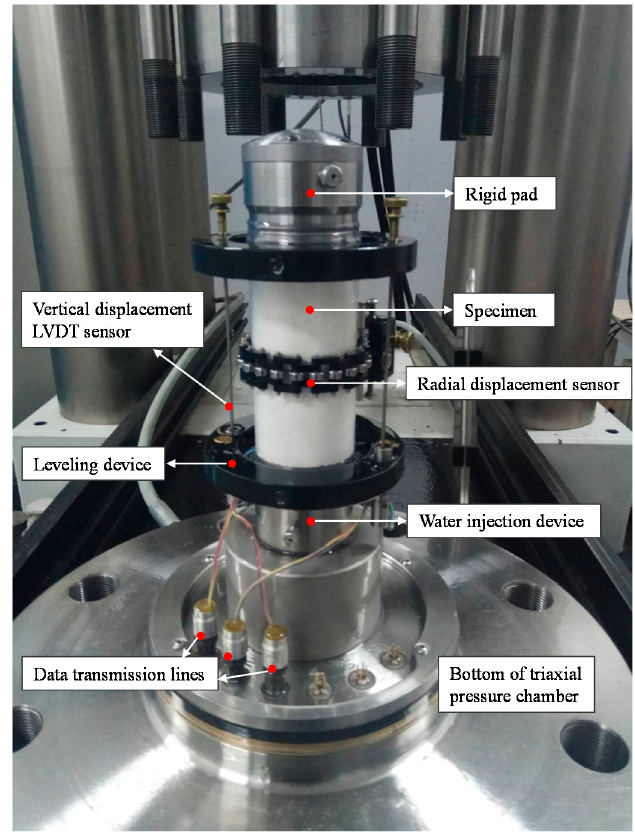
Figure 3. Photograph of experimental devices installed.